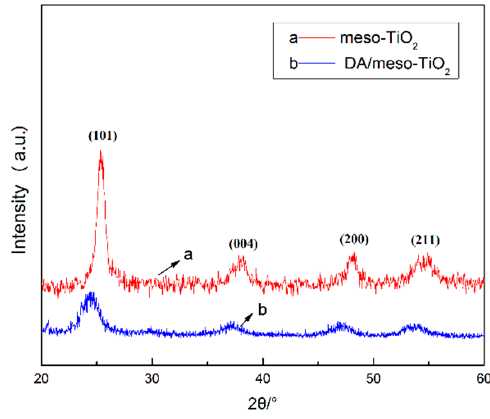
Figure 11 Figure 5. XRD patterns of the specimens: ( a ) meso-TiO